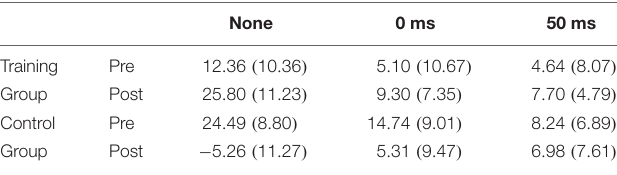
TABLE 1 | Mean points of subjective equality (PSEs) with associated standard errors for each sound condition, both pre- and post-test (none: